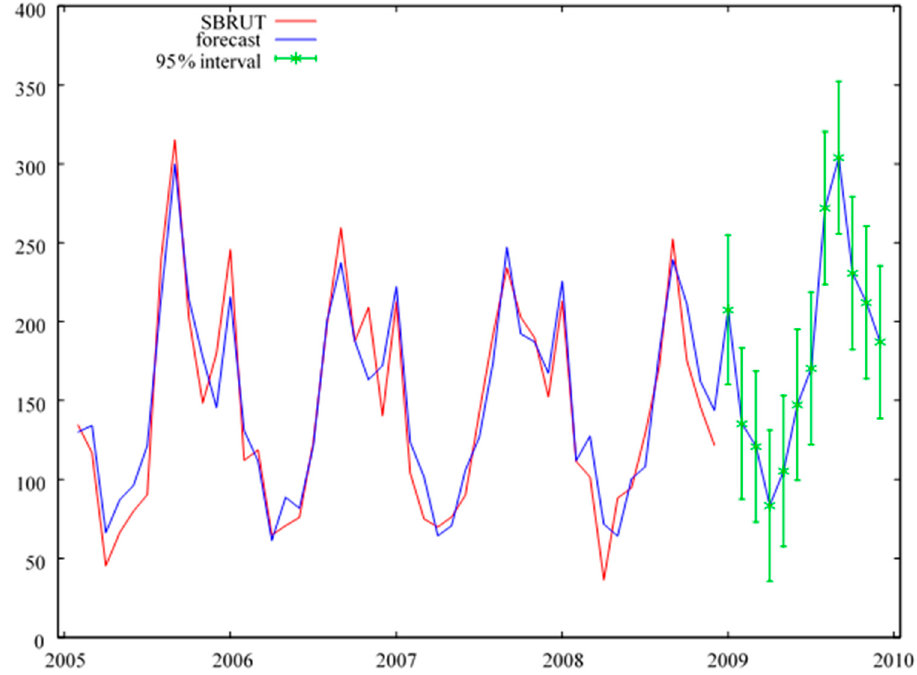
Figure A2. Monthly forecasts of gross sales revenues (s) SBRUT value of machinery and equipment. Source: Table 4.